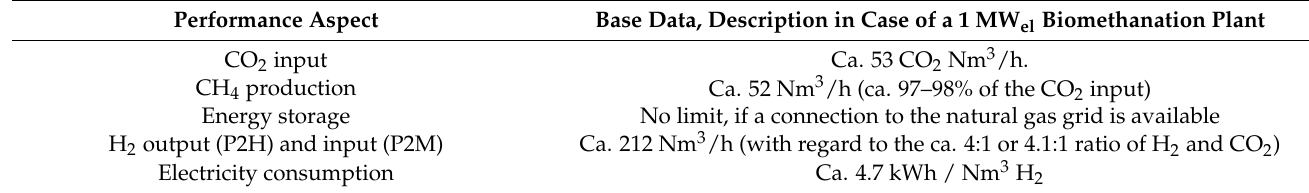
Table 1. P2M performance aspects and related technical data (based on [13]). Performance